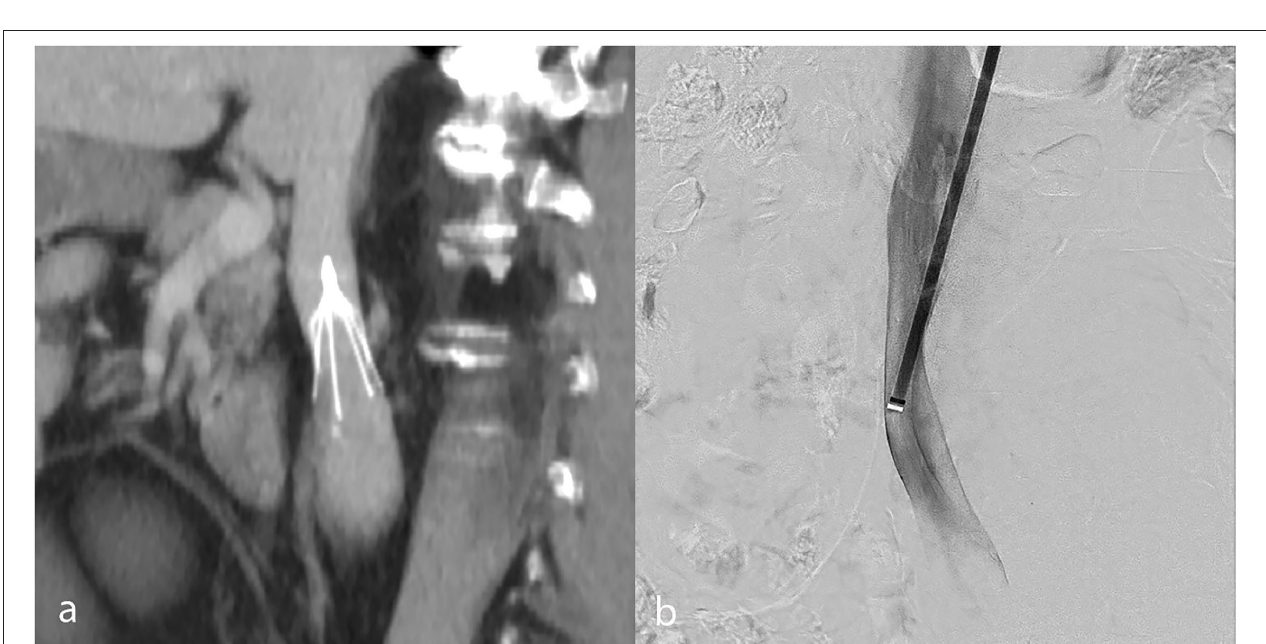
Frontiers in Cardiovascular Medicine |